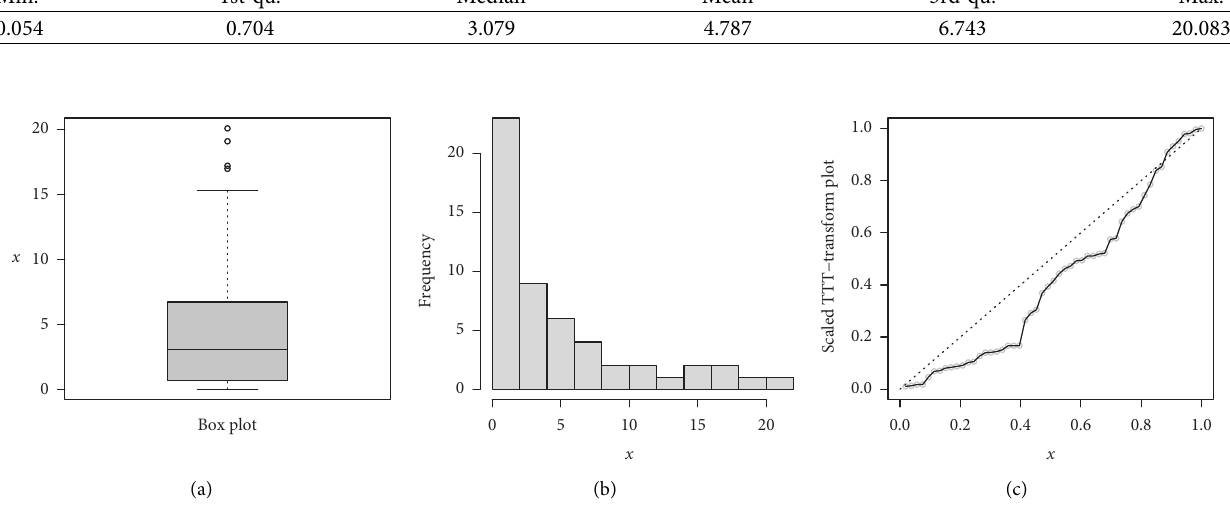
Figure 6: : (a) Box plot, (b) histogram, and (c) TTT plot of the data.